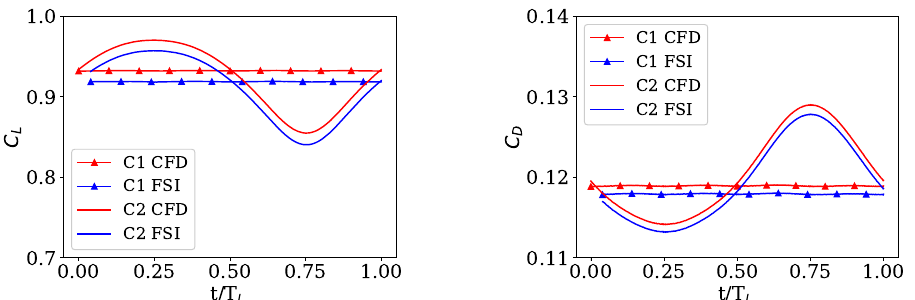
Figure 16. ( left ) Lift and ( right ) drag coefficients versus time for (C1) crosswind flight with uniform inflow and (C2) crosswind flight with logarithmic inflow. The FSI simulation predicted lower lift and drag coefficient in both configurations.